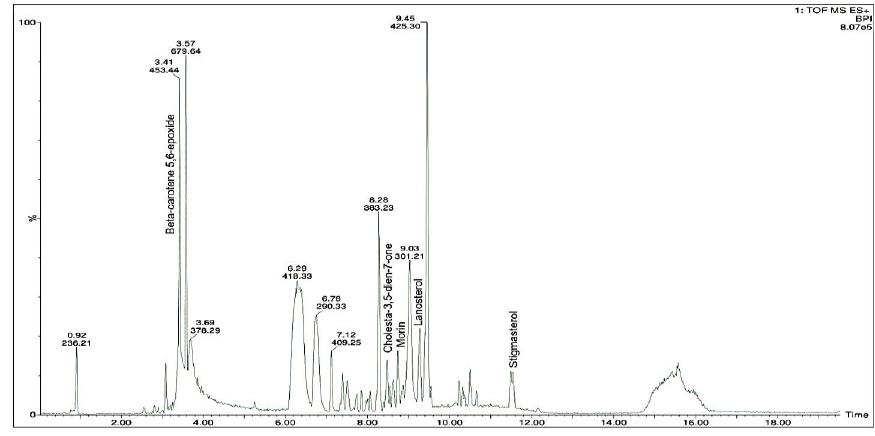
Figure 1. LC-MS chromatographic representation of AME extract in positive mode.